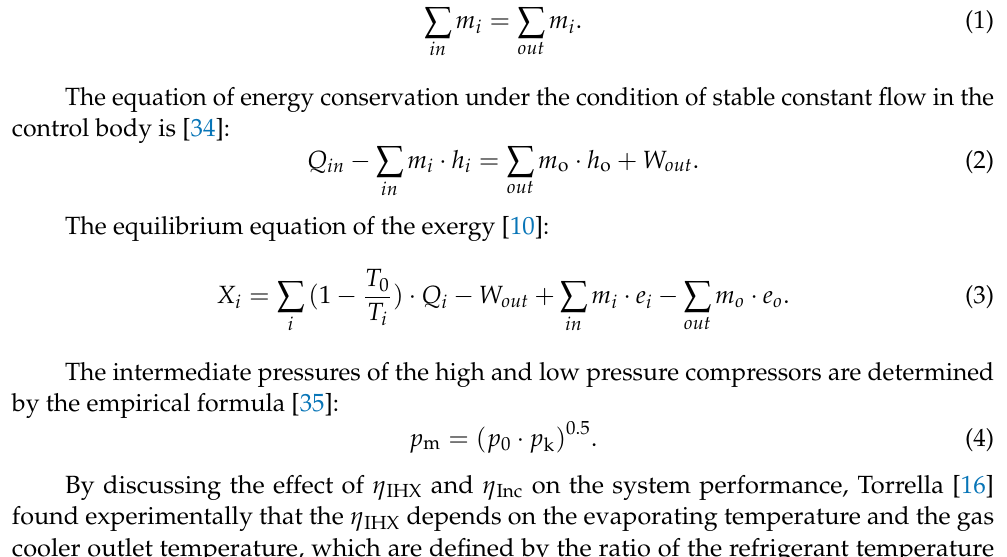
Figure 2. Flow chart of the energy and exergy analysis model for CO 2 refrigeration system.